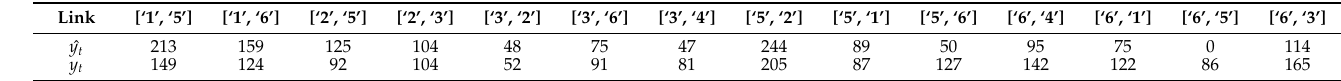
Table 4. Prediction performances of the dynamic traffic assignment